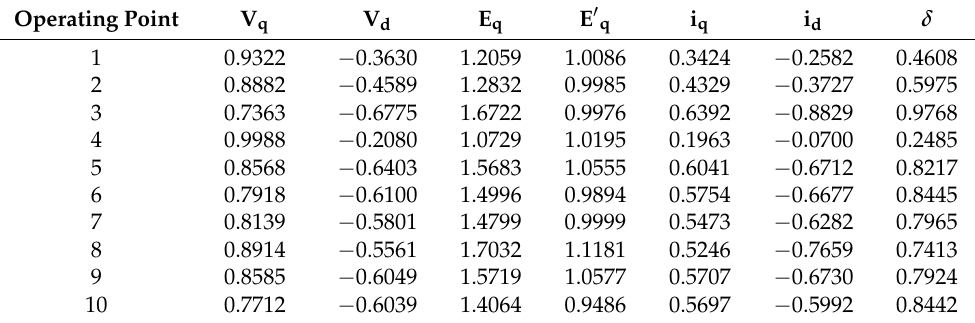
Table A1. The 10 operating points of the synchronous generator for the SMNB model.